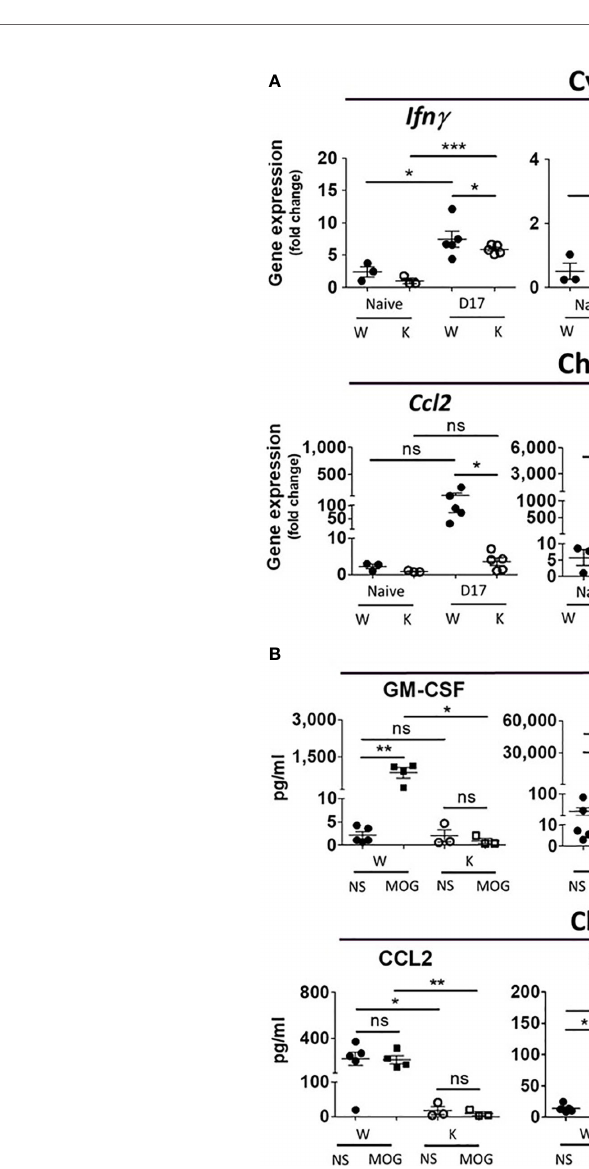
FIGURE 5 | Nox2 de fi ciency diminishes EAE-elicited increase in mRNA expression in the spinal cord and secreted proteins of cytokine and chemokines from CNS mononuclear cells on disease peak (17 dpi). (A) mRNA levels (mean ± SEM) of spinal cord (L4-level section, 0.5 m m thick tissues) at 17 dpi after MOG inoculation were determined by RT-PCR. Cytokines: Ifn g , Il-4, Il-17a ; chemokines: Ccl2, Ccl5, Cxcl10 . All data were normalized as fold of Naïve-W group. (n = 3 to 5 for each group) (B) The amount of cytokines (GM-CSF, IFN g , IL-17A) and chemokines (Ccl2, Ccl5, Cxcl10) secreted from primary mononuclear cells isolated from the CNS collected at 17 dpi after MOG inoculation were quanti fi ed by ELISA assays. (n = 3 to 5 for each group). Cell culture condition was described in the results. NS, no drug treatment; MOG: 10 m g/ml. p value: *** < 0.001, ** < 0.01, * < 0.05, ns, not signi fi